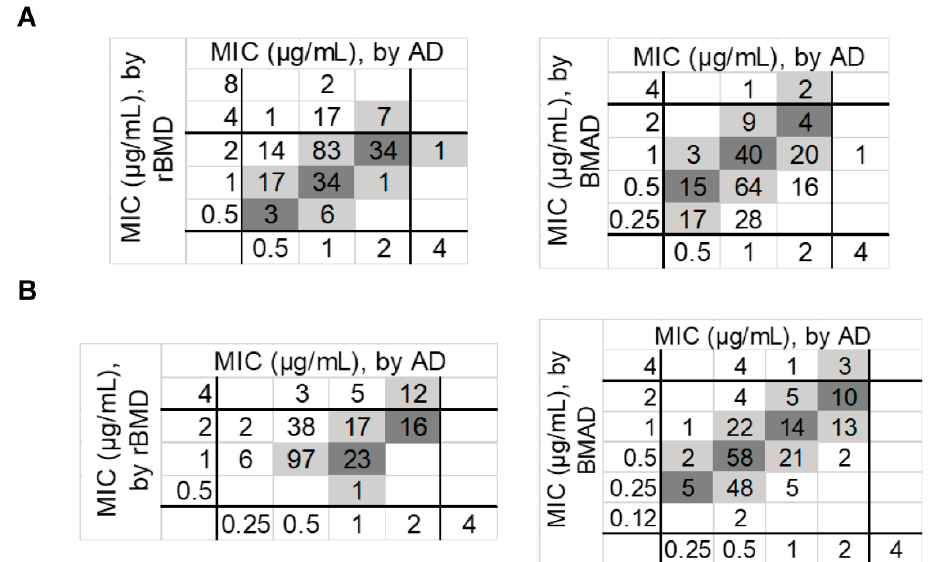
Figure 1. Scatterplot of MIC values for polymyxin B ( A ) and colistin ( B ) measured by AD versus rBMD, and AD versus BMAD using all study isolates ( n = 220). The coordinate axis shows the MIC range of the test method. Dark gray, absolute agreement; light gray, essential agreement. BMAD: broth macrodilution; rBMD: reference broth microdilution; AD: agar dilution.